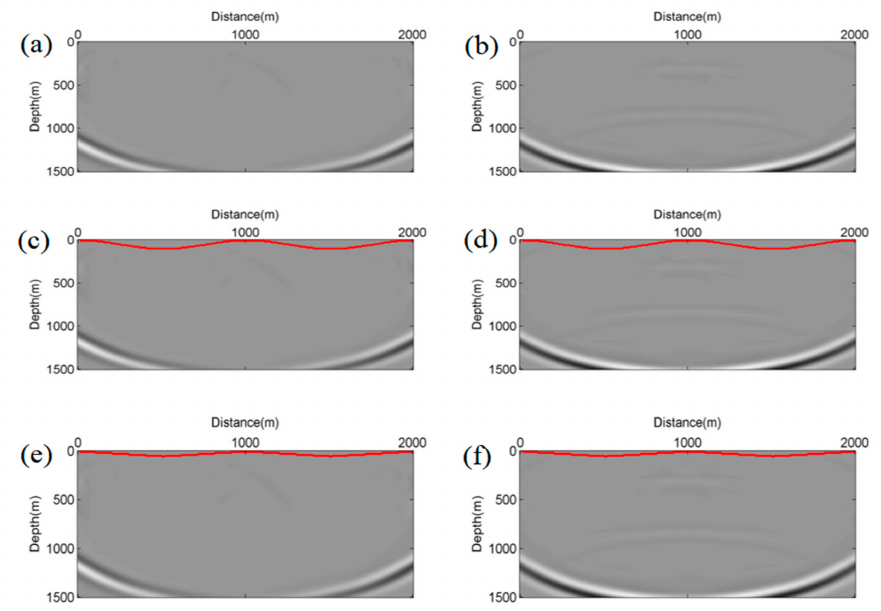
Figure 7. Forward P-wave wavefield at 600 ms for graben elastic models with different topographies. The left panels are the horizontal P-wave particle velocity, and the right panels are the vertical P-wave particle velocity. Panels ( a , b ) are the forward P-wave wavefield for graben elastic model with a horizontal topography, panels ( c , d ) are the forward P-wave wavefield for graben elastic model with a sinusoidal topography, and panels ( e , f ) are the forward P-wave wavefield for graben elastic model with a triangular topography. The red line is the surface